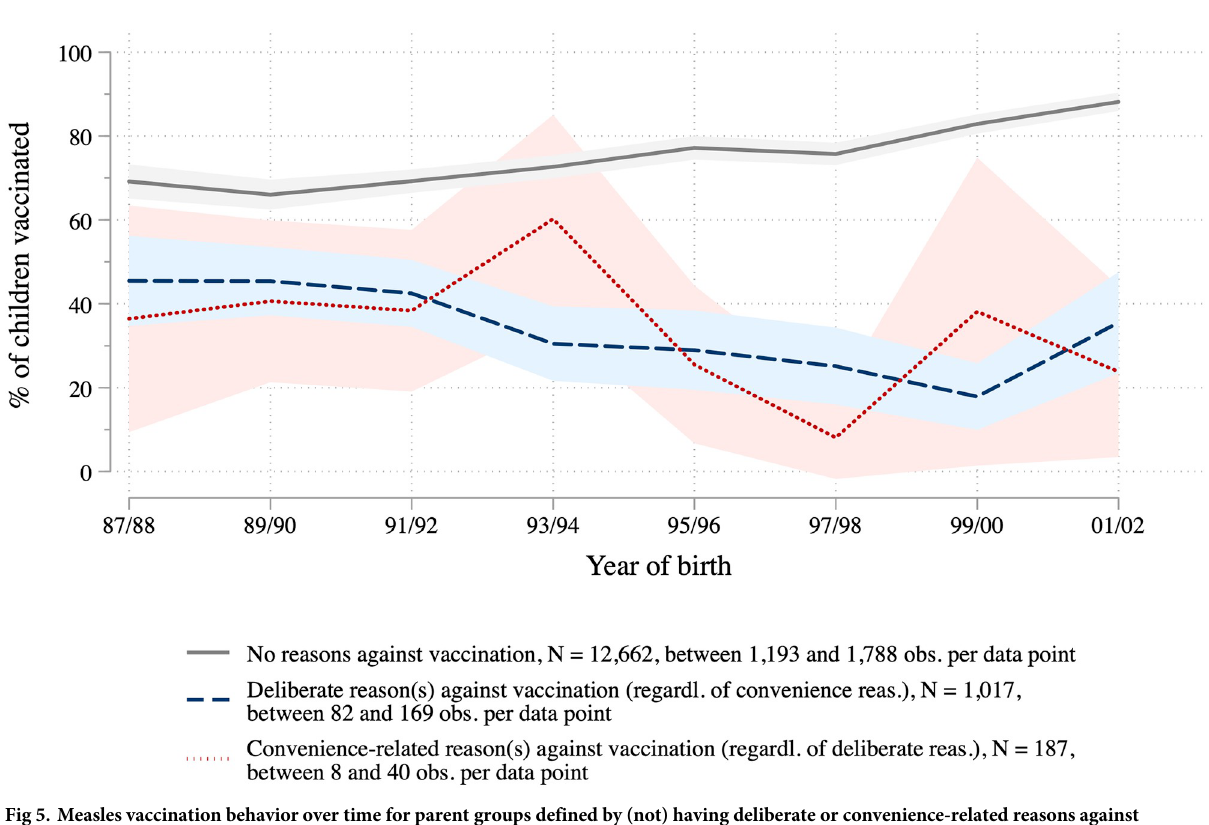
Fig 5. Measles vaccination behavior over time for parent groups defined by (not) having deliberate or convenience-related reasons against vaccination. KiGGS data weighted, point estimates and 95 percent confidence intervals.